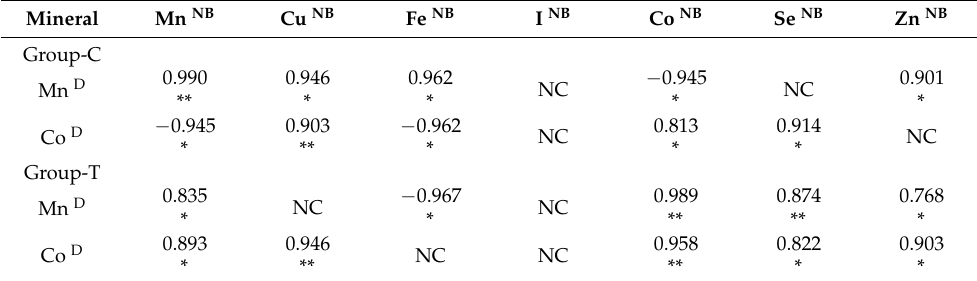
Table 6. Correlation coefficient of some trace elements for female camels and their calves blood serum. Mineral Mn NB